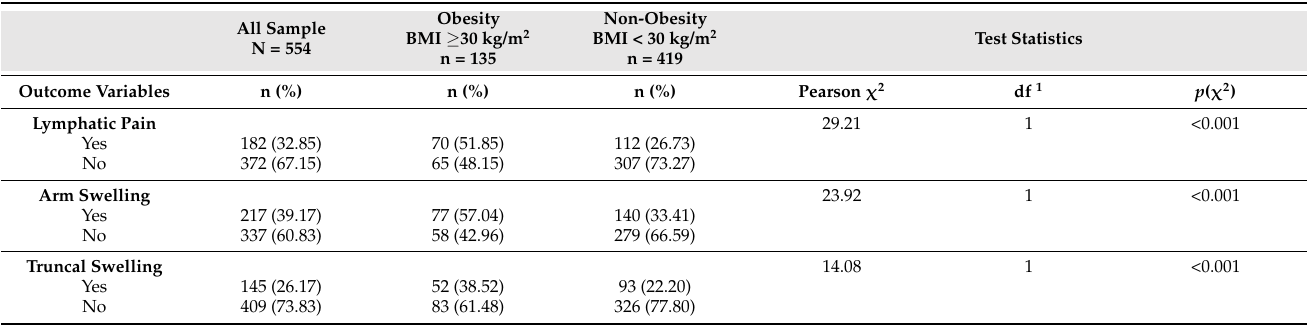
Table 3. Differences in lymphatic pain, arm swelling and truncal swelling between women with obesity and non-obesity ( N = 554).